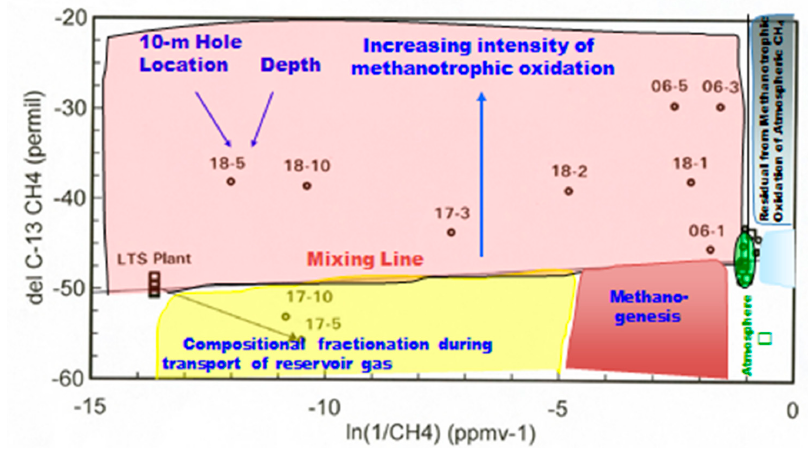
Figure 6. δ 13 C of CH 4 vs. ln(1/CH 4 ) for 10-m holes at Teapot Dome (modified from Klusman [19]).